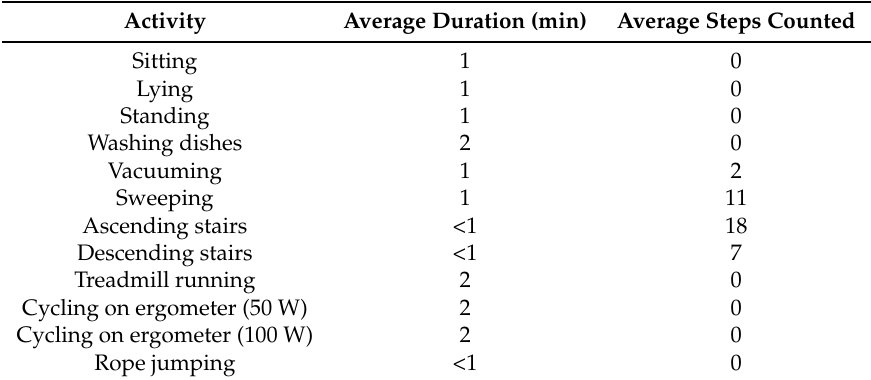
Table 4. Average number of steps counted per participant for non-walking activities.